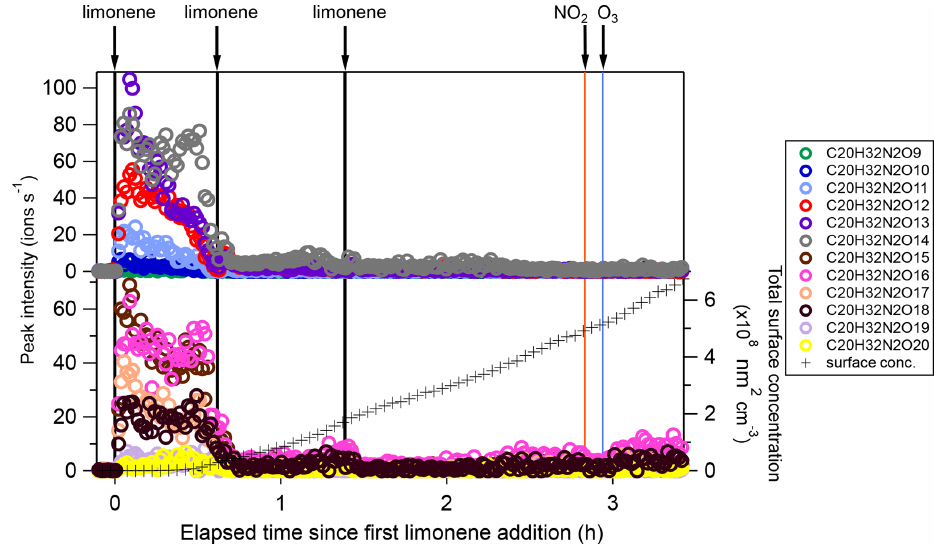
Figure 5. Time series of peak intensity of the C 20 H 32 N 2 O x family compounds during the periods P1 to P3. The cross markers (lower right y axis) indicate total particle surface